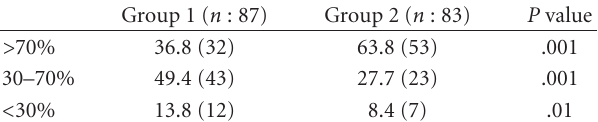
Table 2: Number of patients with resolution in 120th minute.